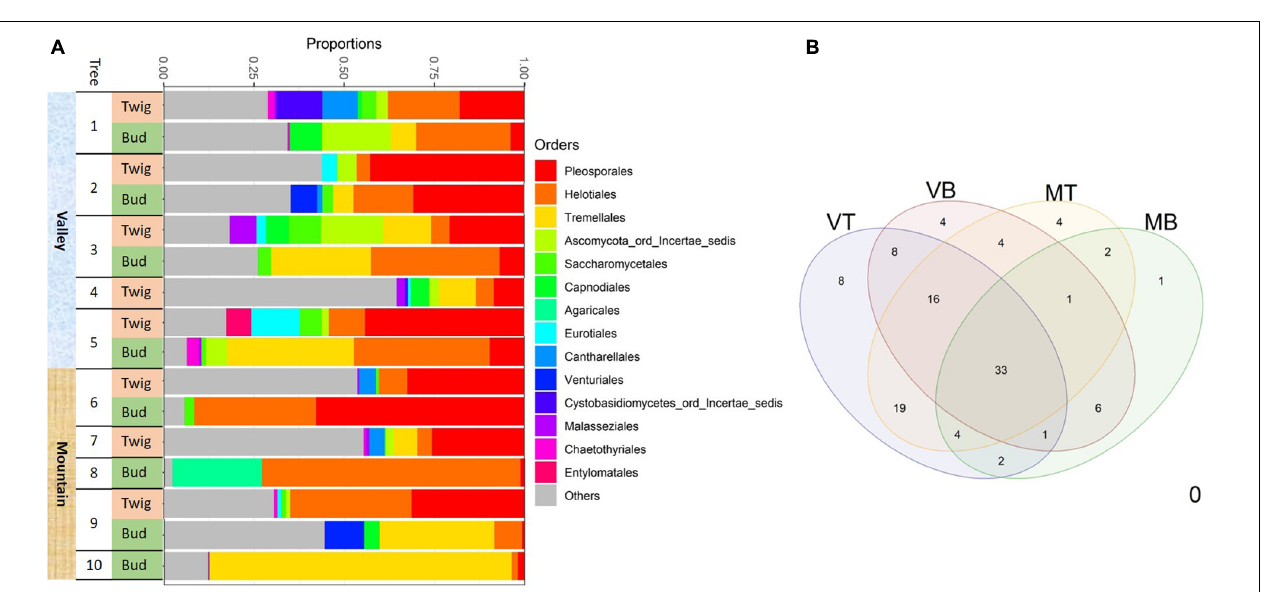
FIGURE 4 | Fungal taxonomic composition showing (A) the most 14 abundant taxonomic orders associated with the two sites for each of the two substrates: buds and twigs. More consistent and diverse taxonomic orders were found in twigs but more dynamic orders in buds; this was the case for both valley and mountain sites. Pleosporales was the most abundant order in the twig samples. Helotiales and Tremellales were more common in bud samples. (B) Venn diagram of shared taxa in four “sites-organs.” MB, mountain buds; MT, mountain twigs; VB, valley buds; VT, valley